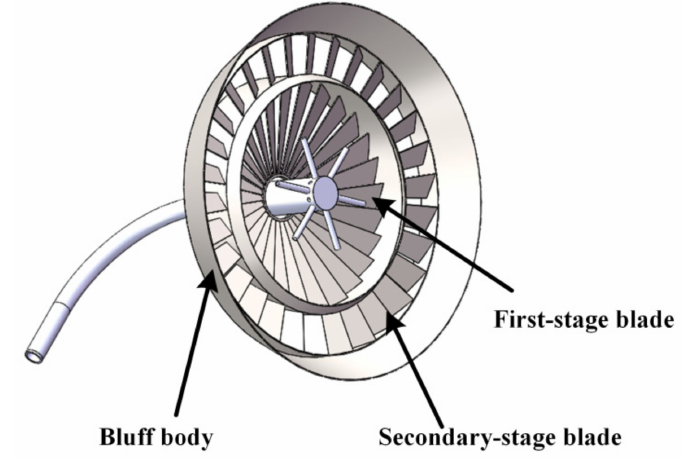
Figure 17. Three-dimensional structure of swirler with bluff